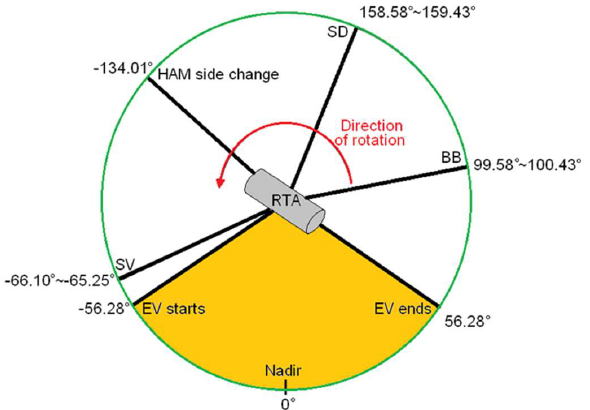
Figure 3. A simplified Rotating Telescope Assembly (RTA) scan angle at each view [3].